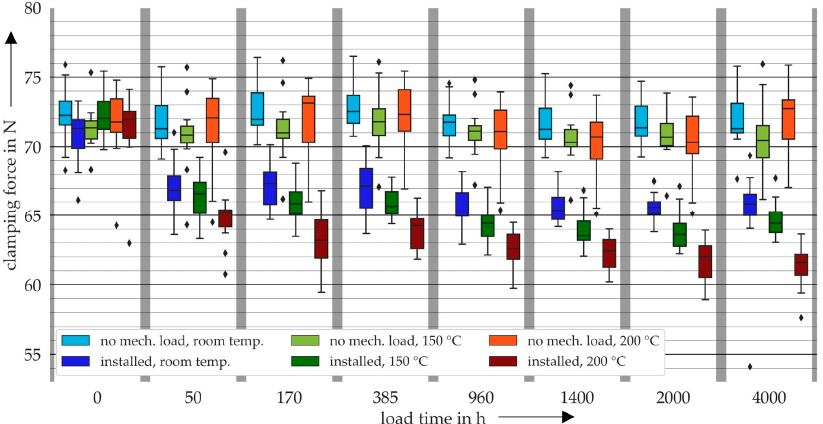
Figure 8. Boxplot with median, upper and lower quartile; respective whiskers, and outliers of clamping force (a tensile force that is applied at the installed position of the clamp) for the load groups depending on the load period.